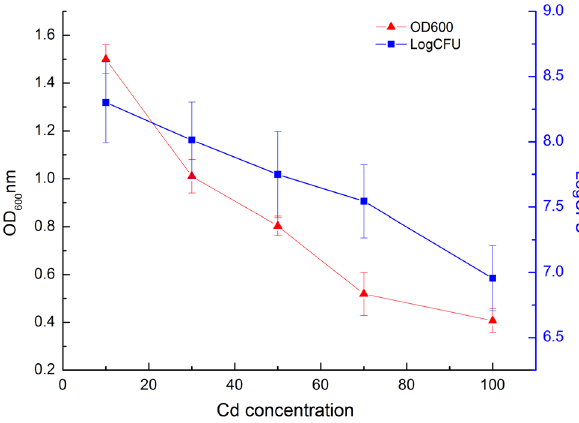
Figure 3: Values of OD 600 nm and Log CFU of bacterium “ N3 ” under di ff erent Cd concentrations ( µM ) in the liquid